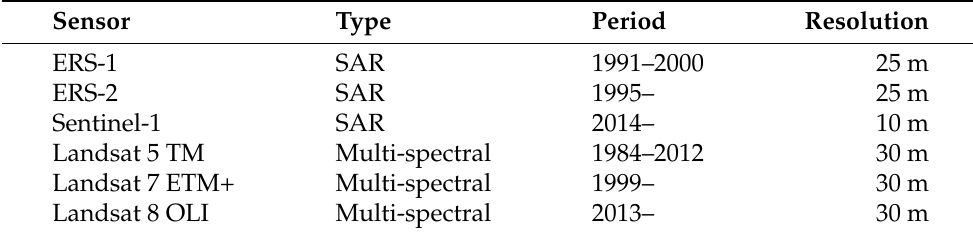
Table 2. Characteristics of the sensors used in the